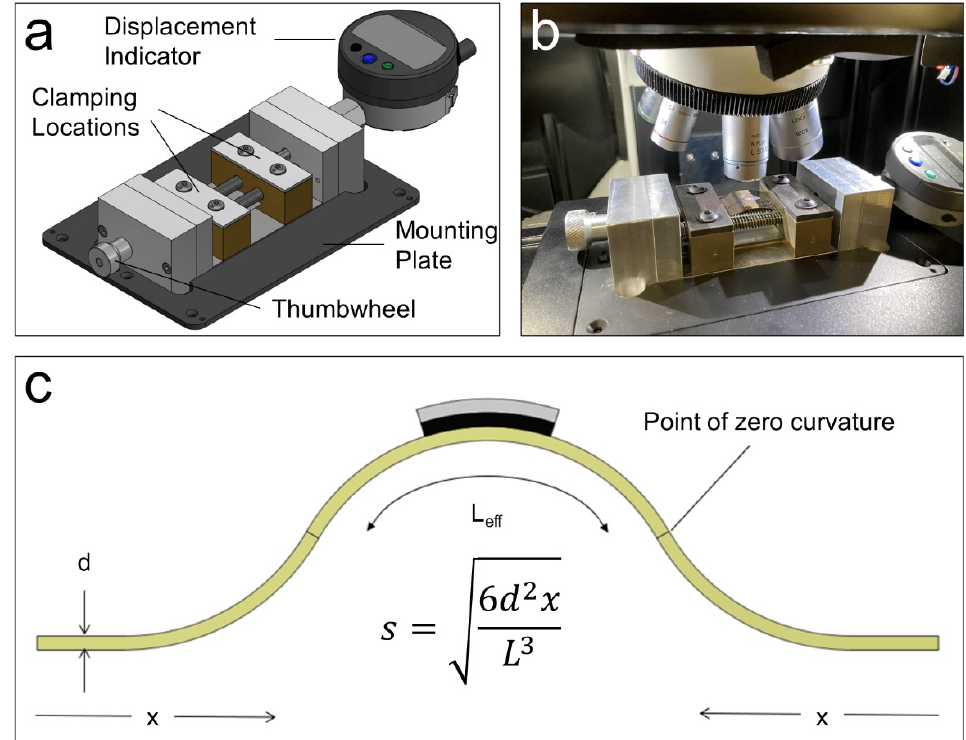
Figure 2. A custom-built jig used for inducing the strain effect on the prepared thin films. ( a ) A 3D model of the designed jig, including its main parts. ( b ) A photograph of the experimental setup, where a custom-built jig is mounted onto the motorized x-y-z stage of a commercial Raman spectroscopy instrument. Laser beam path lighted with the vertical axes of the microscope objective. ( c ) A schematic illustration of the prepared 2D heterostructure films on PET substrates and the relation between the strain s on the sample and the displacement x of the jig is also shown.